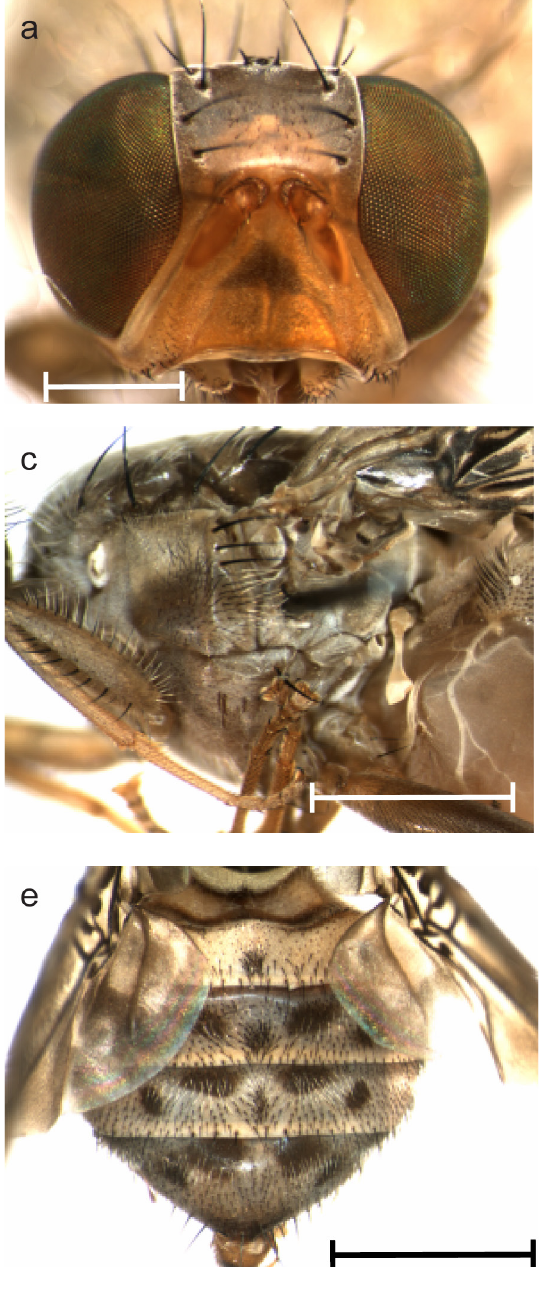
Fig. 6. Ceratitis serrata De Meyer, 1996. a . Head, frontal view. b . Head and thorax, anterodorsal view. c . thorax, lateral view. d . thorax, dorsal view. e . abdomen, dorsal view. Scale bars: a = 0.5 mm; B–D = 1